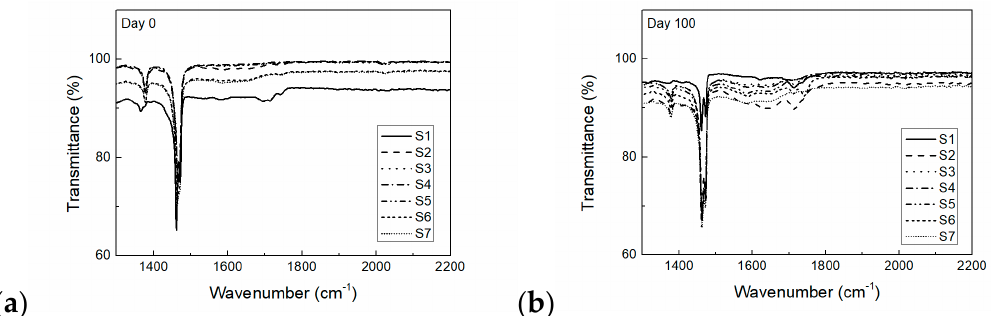
Figure 3. Fourier-transform infrared (FTIR) spectroscopy of PCMs ( a ) before and ( b ) after artificial aging test.